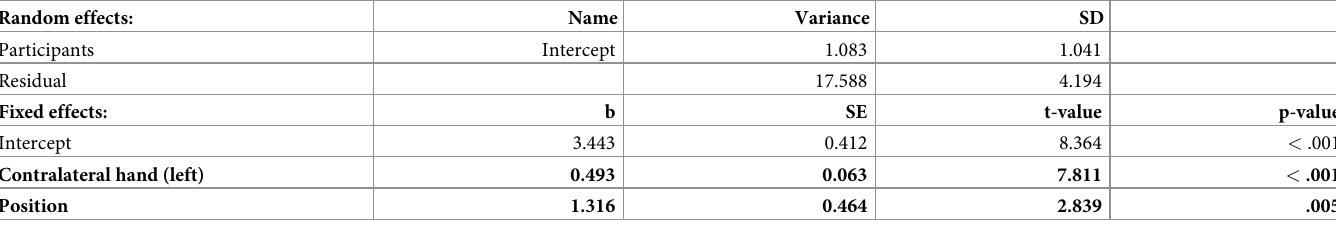
Table 4. Model 1.4. Effect of Position on the right grip force (after controlling for the contralateral force) in the time window 60–130 ms (Experiment 1). Random